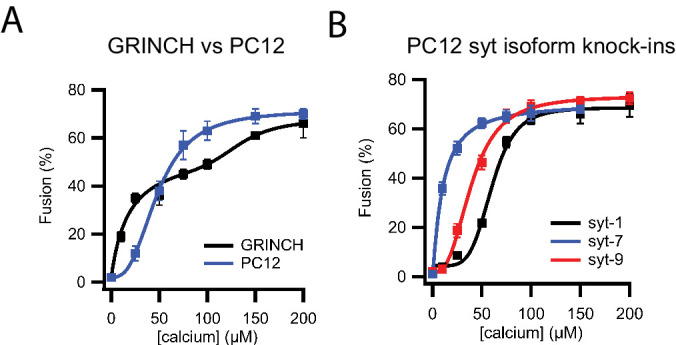
Calcium dependence of granule fusion efficiency is determined by syt isoform.(A) Comparison of fusion efficiencies for insulin granules purified from untreated GRINCH cells and dense core granules from PC12 cells expressing NPY-Ruby as a function of calcium concentration measured in a single vesicle/supported membrane TIRF microscopy-based fusion assay. (B) Fusion efficiencies of PC12 dense core granules expressing only single synaptotagmin isoforms as a function of calcium concentration in a single vesicle/supported membrane fusion assay.